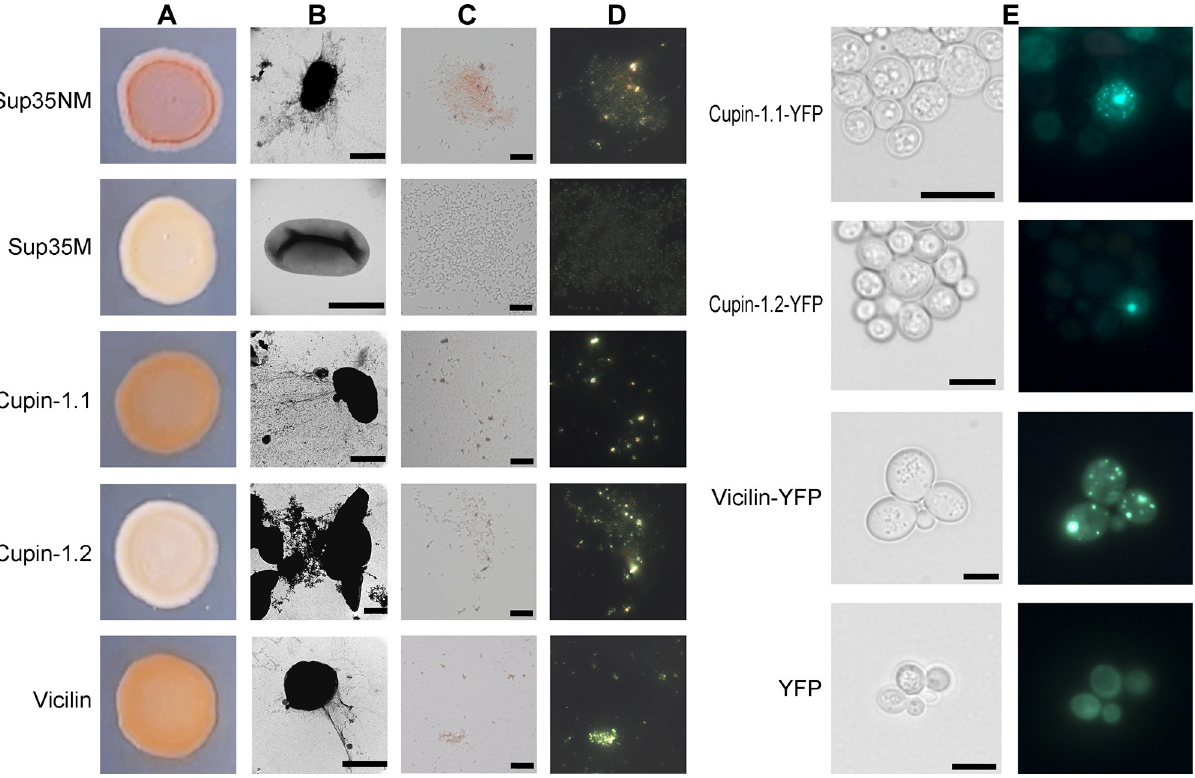
Fig 4. Amyloid properties of Vicilin and its Cupin domains produced in bacteria and yeast cells. (A) CR plate with E . coli cells secreting Vicilin, Cupin-1.1, and Cupin-1.2. The cells secreting either Sup35NM (amyloid) or Sup35M (soluble) proteins were used as the positive and negative controls, respectively. (B) TEM images of the Vicilin, Cupin-1.1, and Cupin-1.2 fibrils secreted by E . coli cells. Scale bars are equal to 500 nm (all images, with the exception of Cupin-1.2) or 1 μ m (Cupin-1.2). (C and D) Vicilin, Cupin-1.1, and Cupin-1.2 fibrils secreted by E . coli cells bind CR and exhibit birefringence in polarized light. Transmitted light (C) and polarized light (D) images are shown, magnification 800 × was used. Scale bars are equal to 20 μ m. (E) The Vicilin, Cupin-1.1, and Cupin-1.2 proteins fused with YFP aggregate in the S . cerevisiae cells. Transmitted light (left) and fluorescent light (right) images are shown. Scale bars are equal to 5 μ m. CR, Congo Red; TEM, transmission electron microscopy; YFP, yellow fluorescent protein.